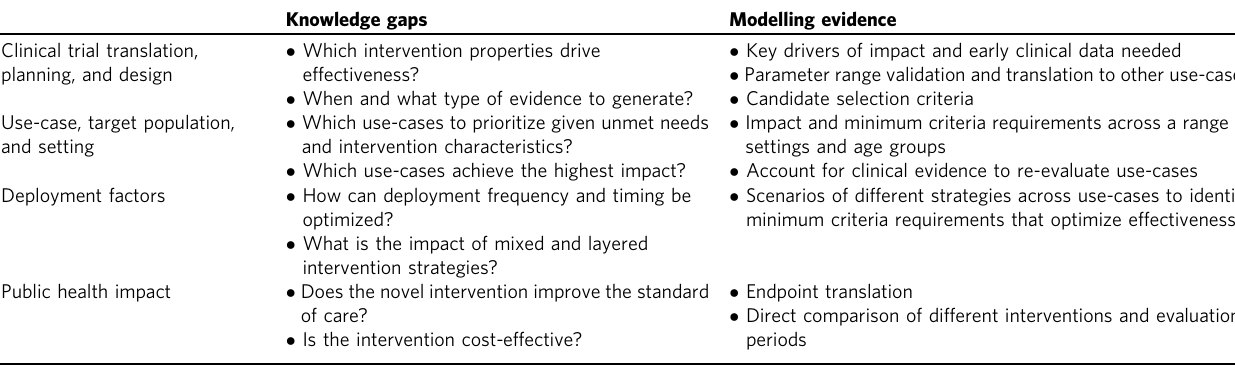
Table 1 Knowledge gaps addressed by integrating modelling at each development stage. Knowledge gaps Modelling evidence Clinical trial translation, planning, and